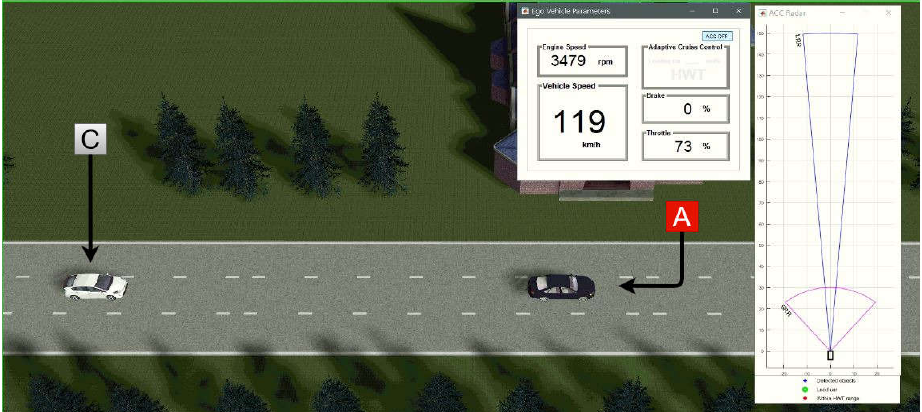
Figure 15. Third phase of the overtaking maneuver.